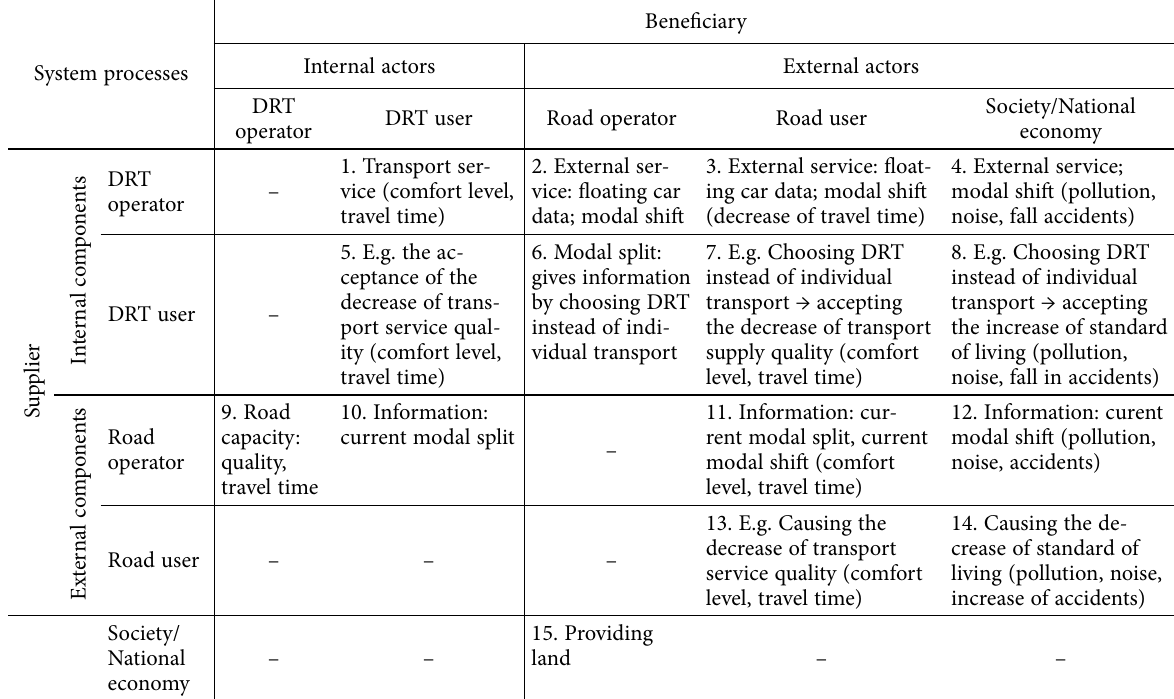
Table 1. The system processes of a DRT system